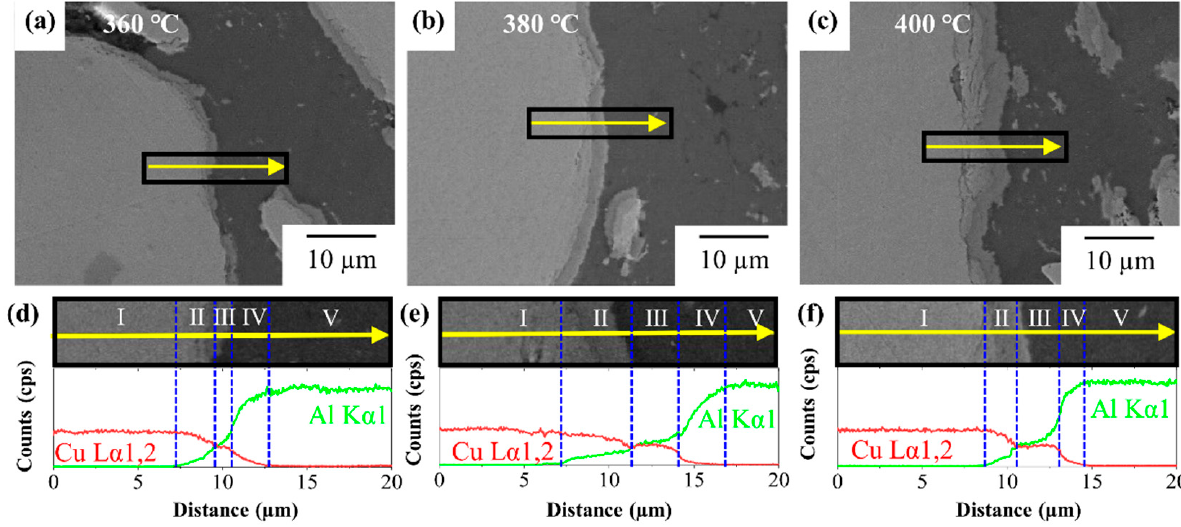
Figure 4. FE-SEM images and EDS line scan result with elements Al and Cu (green line: Al K α 1, red line: Cu L α 1,2) in cross-section of Al-50vol% Cu composites sintered at ( a , d ) 360 ◦ C, ( b , e ) 380 ◦ C, and ( c , f ) 400 ◦ C. The total thickness of the interdiffusion layer in Al–Cu sintered at 360 ◦ C (6.1 µ m)